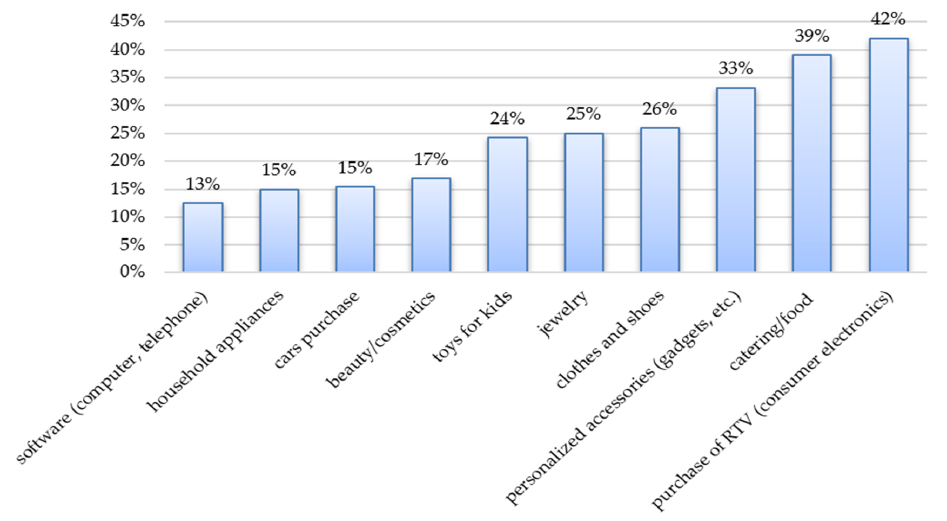
Figure 3. Purchases of personalized products by relevant product groups. Source: own study.